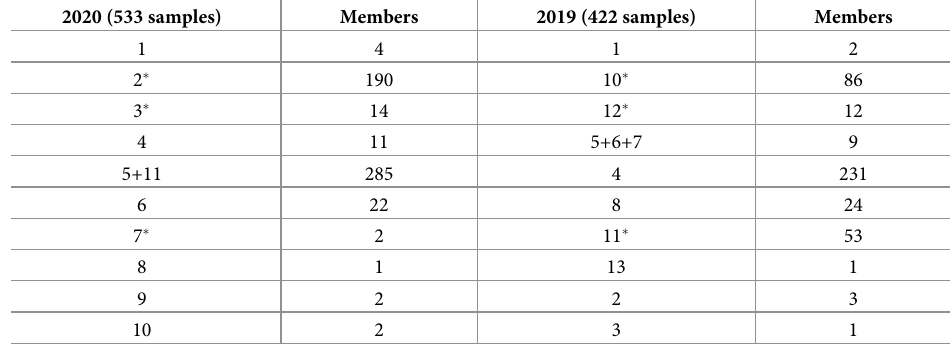
Table 3. Structure of the clustered data with numbers of artefacts/members, based on the average-link cluster analysis with logarithmic concentrations of arsenic (As), antimony (Sb), silver (Ag), nickel (Ni) and bismuth